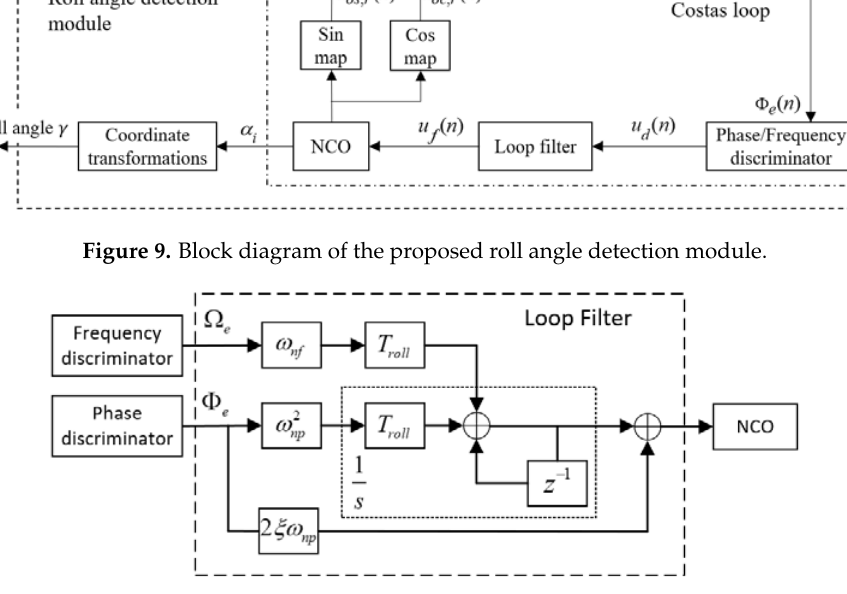
Figure 10. Block diagram of a second-order Phase-Locked Loop (PLL) with first-order Frequency-Locked Loop (FLL) assisted filter.